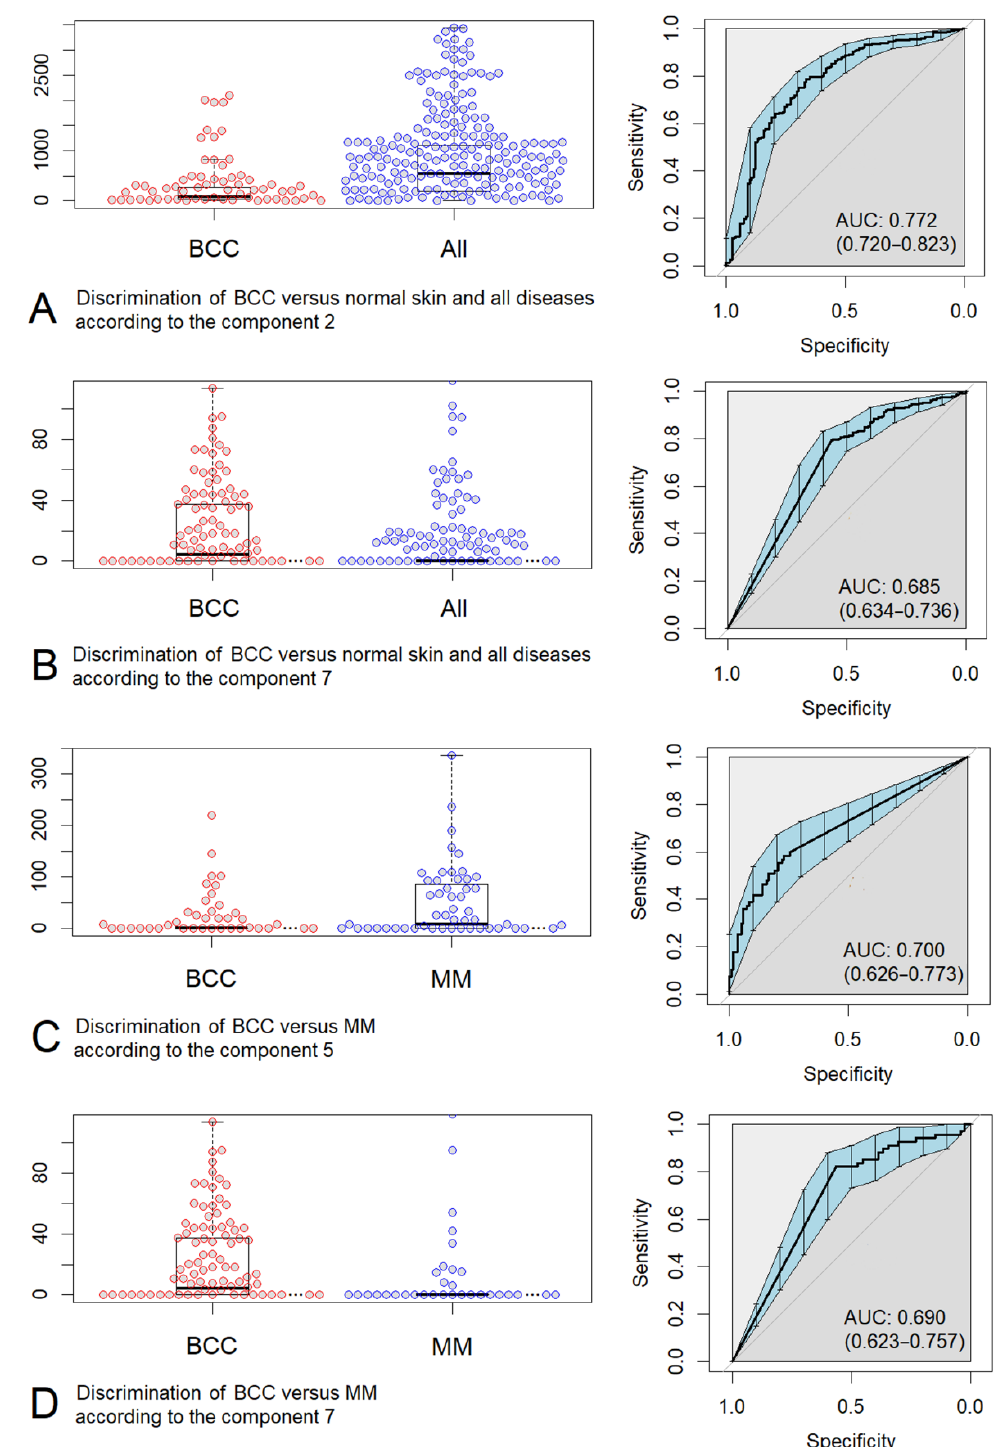
Figure 6. Box-plot diagrams and ROC curves corresponding to several cases of discrimination: ( A ) basal cell carcinoma (BCC) versus normal skin and all diseases (All) according to the MCR Component 2 (melanin), ( B ) basal cell carcinoma (BCC) versus normal skin and all diseases (All) according to the MCR Component 7 (proteins, lipids, nature moisturizing factor, melanin), ( C ) basal cell carcinoma (BCC) versus malignant melanoma (MM) according to the MCR Component 5 (proteins, lipids, nature moisturizing factor), ( D ) basal cell carcinoma (BCC) versus malignant melanoma (MM) according to the MCR Component 7 (proteins, lipids, nature moisturizing factor, melanin).